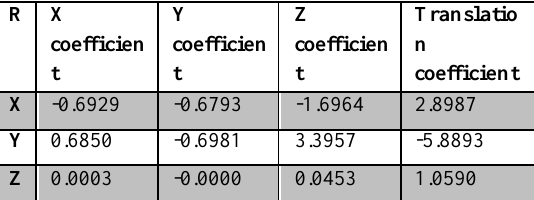
Absolute orientation can be found by computing the rotation